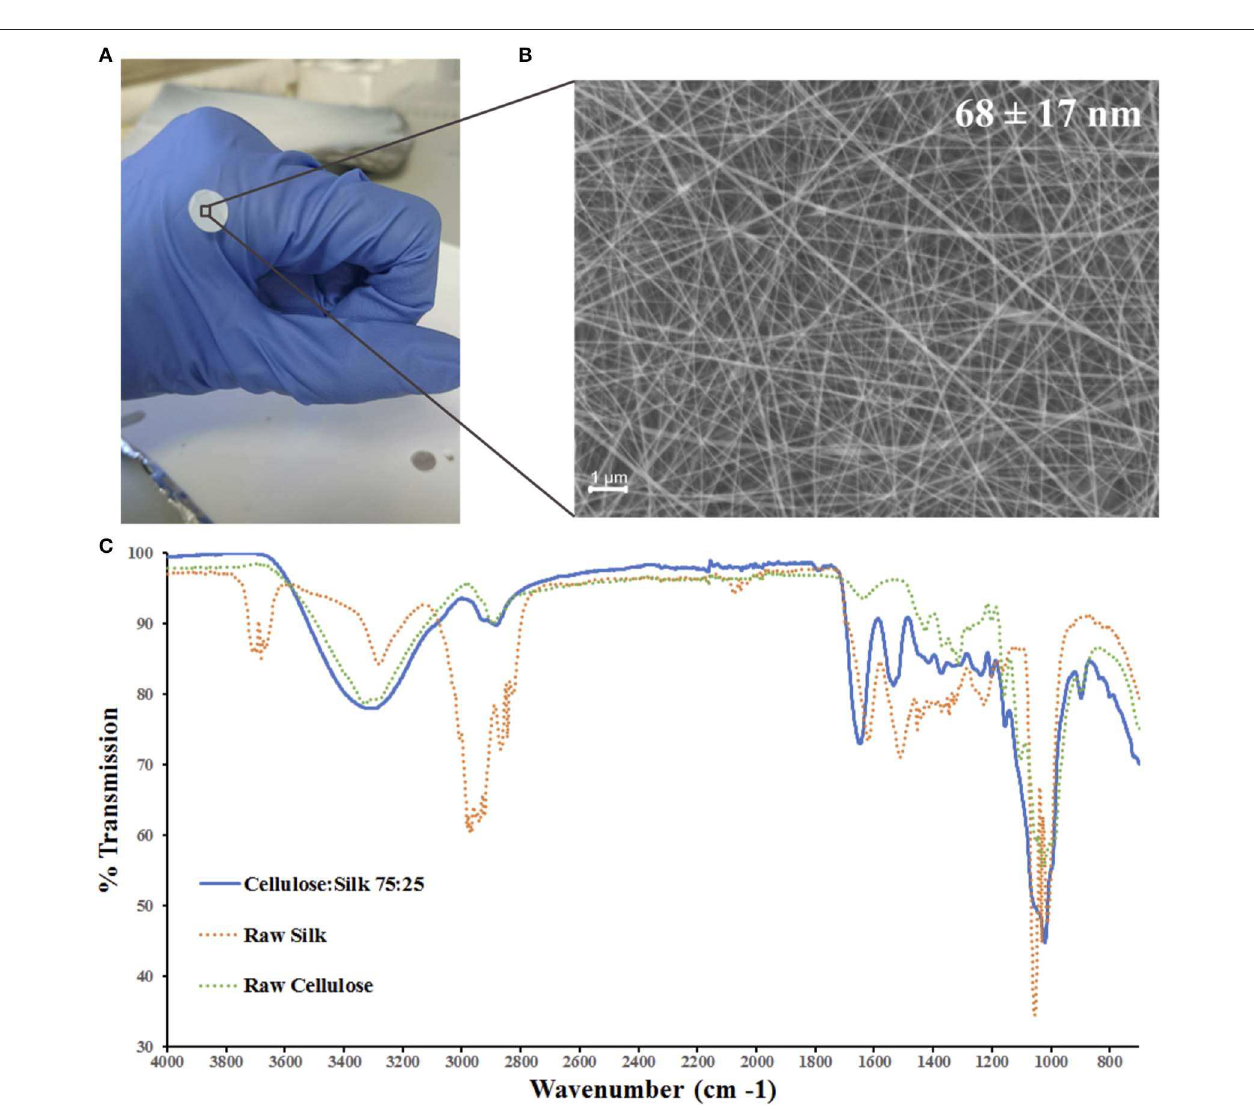
FIGURE 1 | Electrospun cellulose:silk 75:25 composite nanofibres. Polymer solutions were electrospun at 1.0 ml/h flow rate and 2.0kV/cm voltage in a trifluoroacetic acid—acetic acid (TFA + AcOH) co-solvent system. (A) 8mm discs were cut for cell culture studies. (B) Scanning electron microscopy of the nanofibrous material with fiber diameters of 68 ± 17nm ( scale bar inset measures 1 µ m ). (C) FTIR was performed to chemically characterize the nanofibrous mat. Solid line—electrospun fibers, dashed line—raw polymers. Key shown